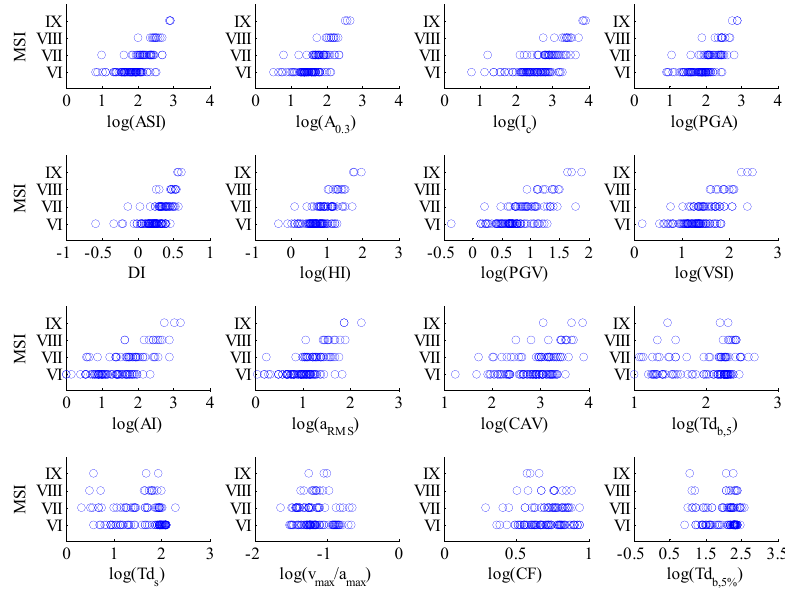
Figure 2. Scatter of macroseismic intensity (MSI) versus ground motion parameters.